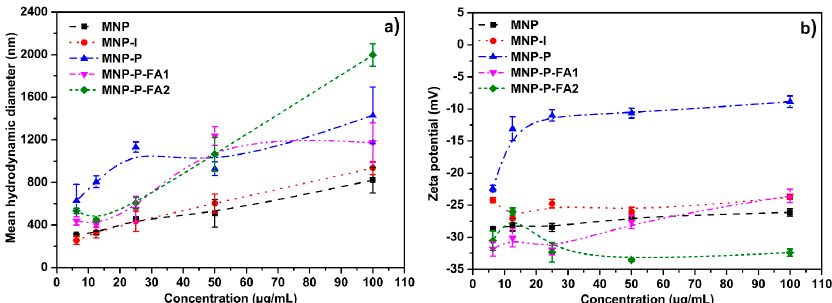
Figure 7. Hydrodynamic diameter ( a ) and Zeta potential ( b ) of MNP (black), MNP-I (red), MNP-P (blue), MNP-P-FA1 (magenta) and MNP-P-FA2 (green).